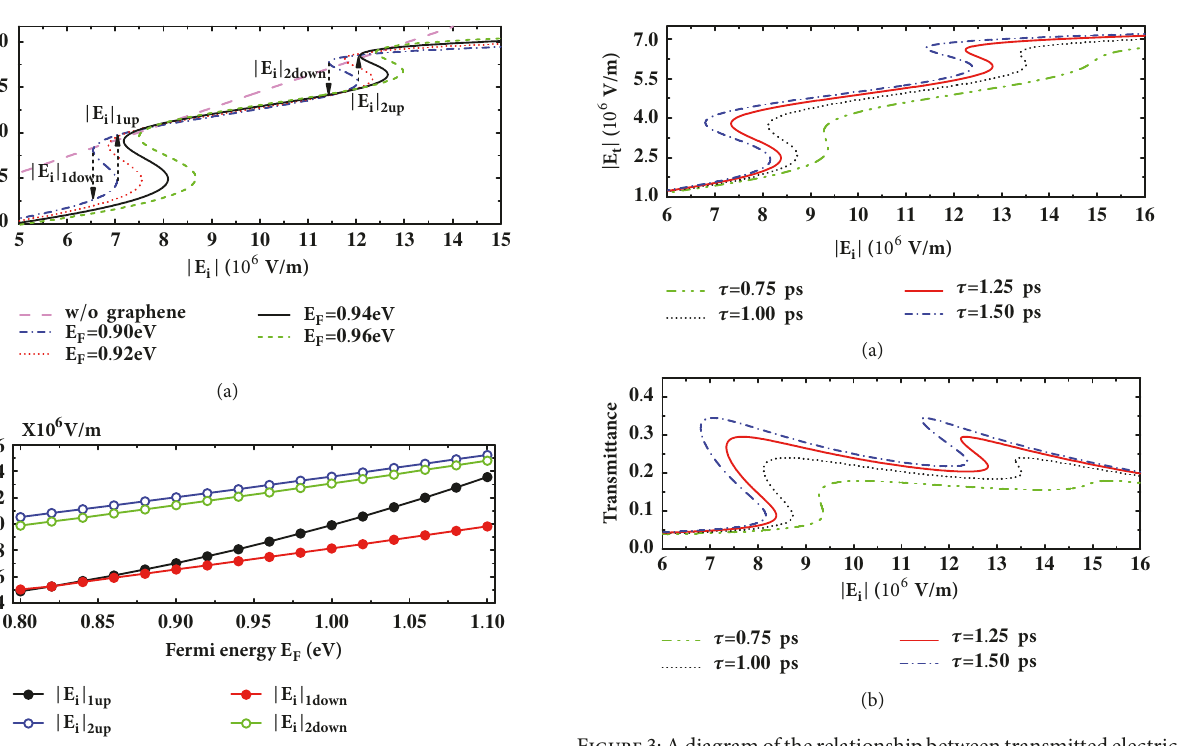
Figure3:Adiagramoftherelationshipbetweentransmittedelectric field (a) and transmittance (b) with incident electric field under different relaxation times 𝜏 . The other parameters are the same as